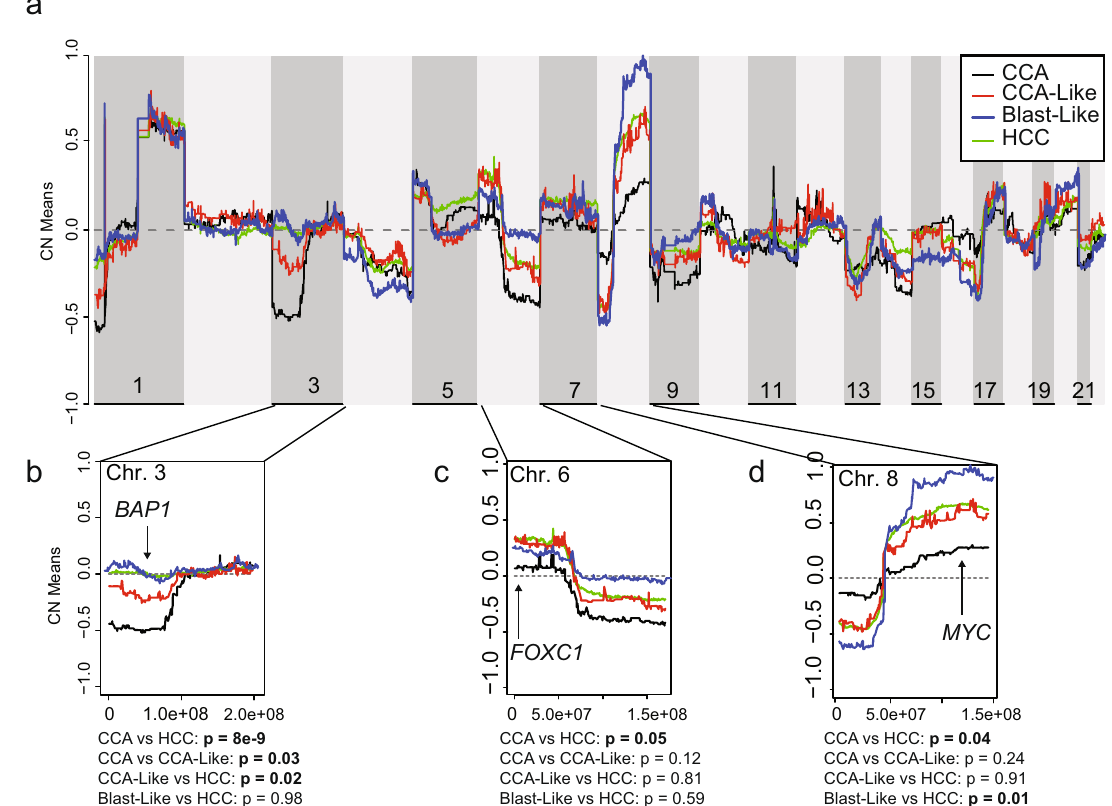
Fig. 5 Copy number landscapes show tissue-speci fi c speci fi city. a Genome-wide copy number values are plotted for CCA (black), CCA-Like (red), Blast- Like (blue), and HCC (green) using the mean quantitative gene-level copy measurements from GISTIC. b − d Expanded view of three chromosomes containing regions signi fi cantly differed by pairwise two-sample t-tests ( p -value <0.05) between CCA and HCC. Potential target genes in signi fi cant segments are